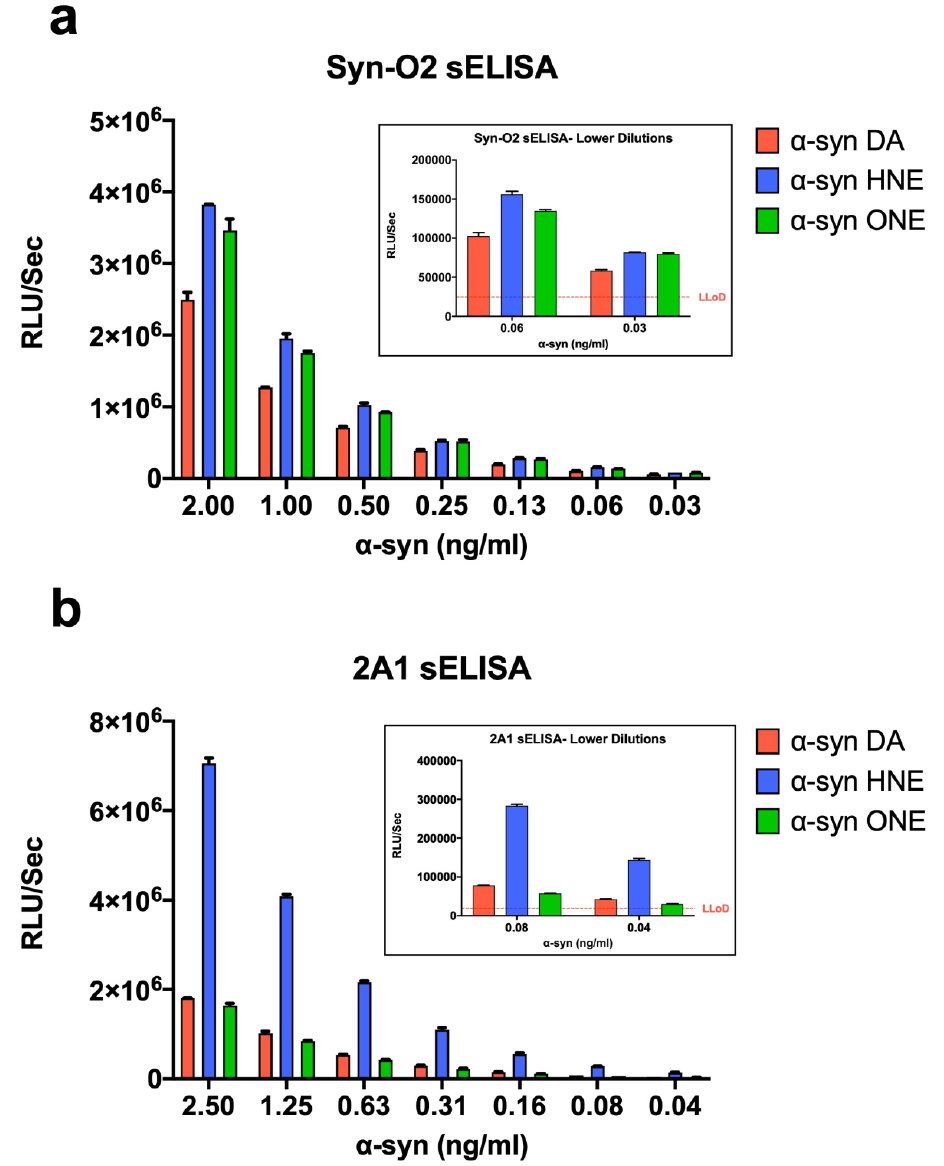
Figure 7. Oligomers as calibrators in a sandwich ELISA (sELISA). ELISA plates coated with ( a ) Syn-O2 (mouse anti-o- α -syn monoclonal antibody) or ( b ) 2A1 (mouse anti- α -syn aggregate- specific monoclonal antibody) was incubated with different concentration (as indicated) of α -syn DA-, HNE-, or ONE-oligomers followed by the addition of a biotinylated antibody and detected with streptavidin–peroxidase polymer. The chemiluminescence expressed in relative light units (RLU/s) was measured by adding an enhanced chemiluminescence substrate to the plate then measured immediately using the VICTOR™ X3 multilabel plate